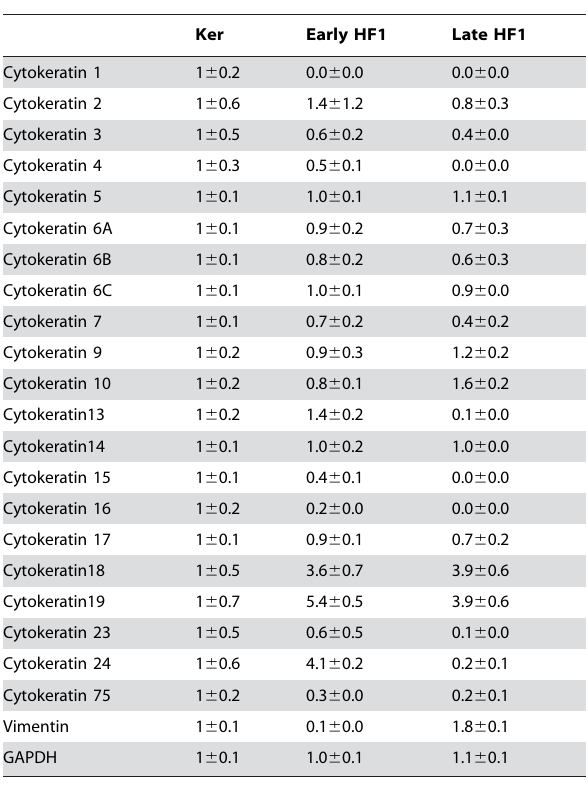
Table 1. Intermediate filament expression Table 2. Expression of desmosomal and adherens